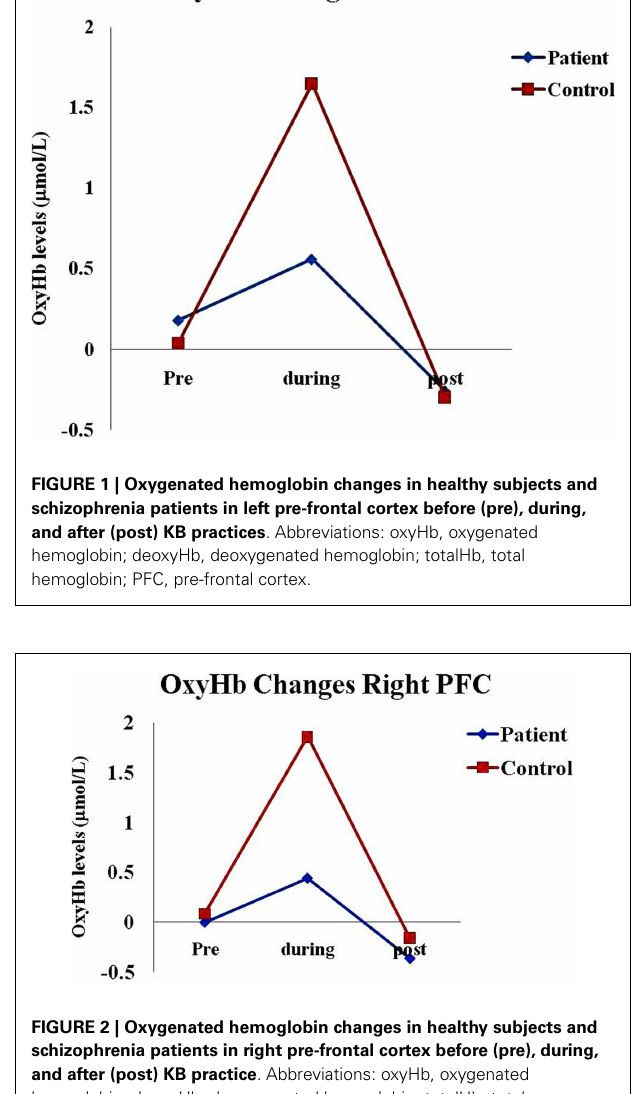
( p = 0.01) and left side ( p = 0.03) ( Table 3